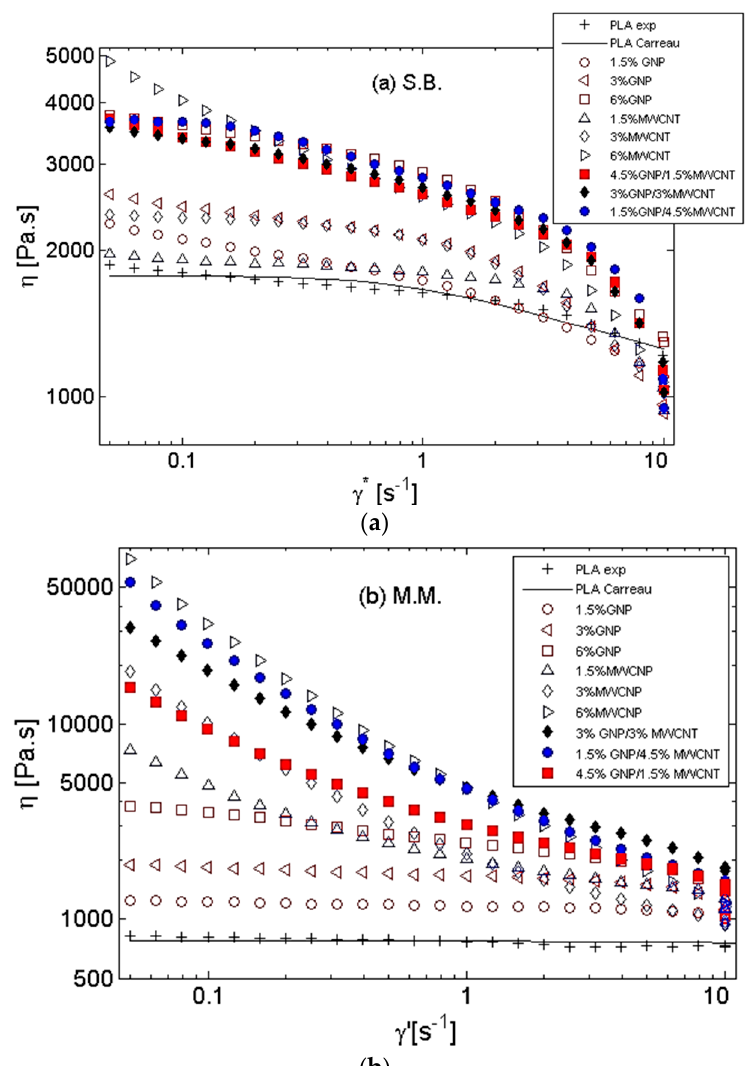
Figure 2. Steady-state viscosity vs. shear rate at 200 °C with varying filler contents and filler combinations for ( a ) solution-blended nanocomposites and ( b ) melt-mixed nanocomposites. Line presents the fit with the Carreau model (Equation (1)) for the neat PLA.